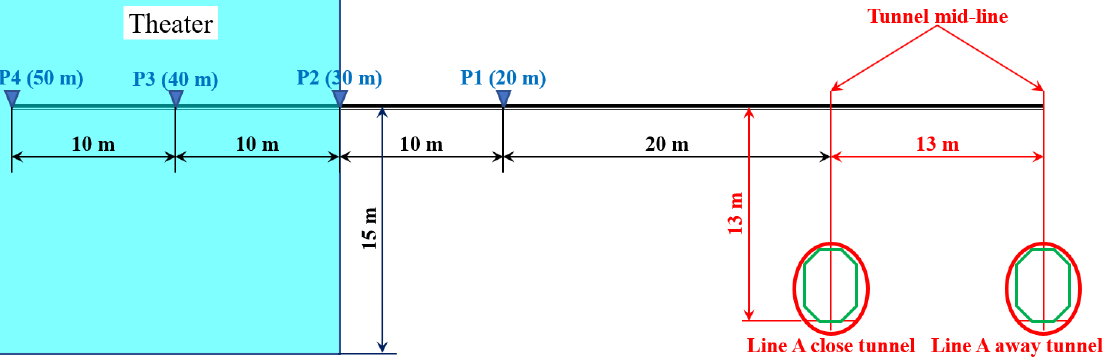
Figure 6. Ground vibration setup in the construction site of the theater.